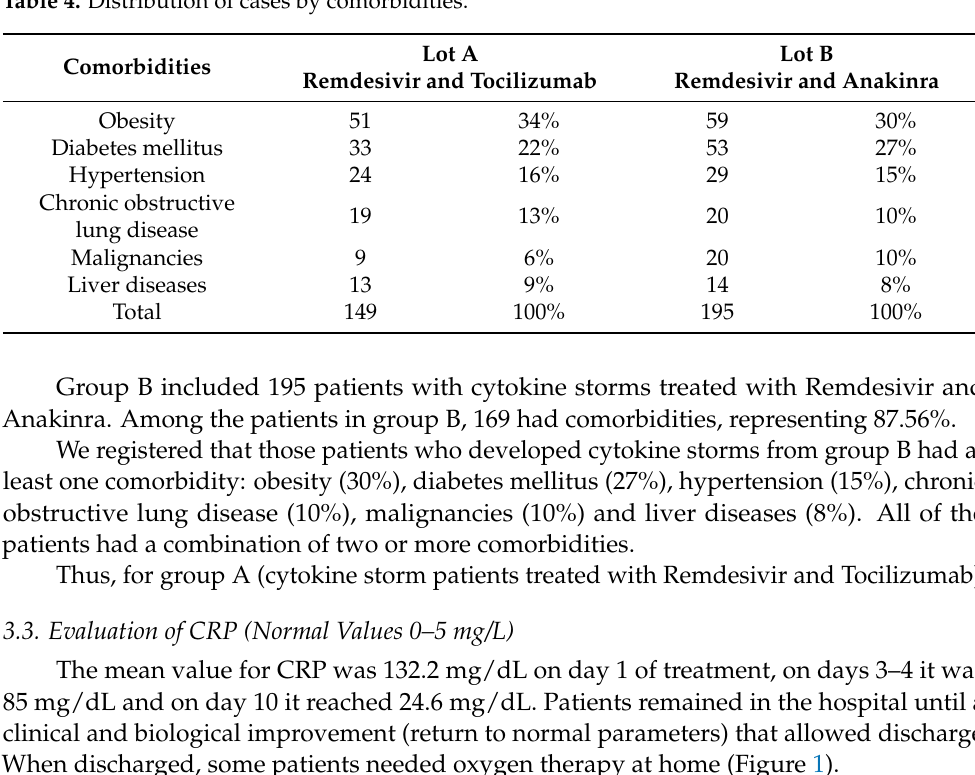
Table 4. Distribution of cases by comorbidities.